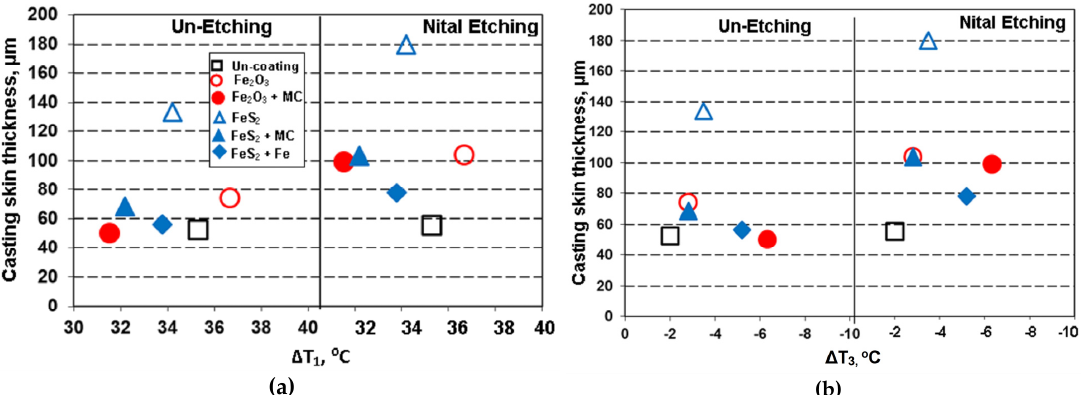
Figure 10. Casting skin thickness for uncoated and different inner-coated ceramic cups, in unetched (graphite) and Nital etching (metal matrix) evaluation conditions ( a ) Δ T 1 ; ( b ) Δ T 3 relationship.